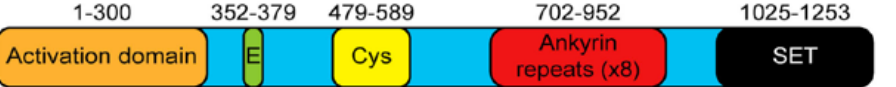
Figure 1. Structure of G9a. The protein contains 1253 amino acids and distinct domains including an N -terminal activation domain, glutamate-rich (23 consecutive Glu residues), and cysteine-rich regions, eight ankyrin repeat units (binding of dimethylated lysine residues), and a C-terminal enzymatic SET domain